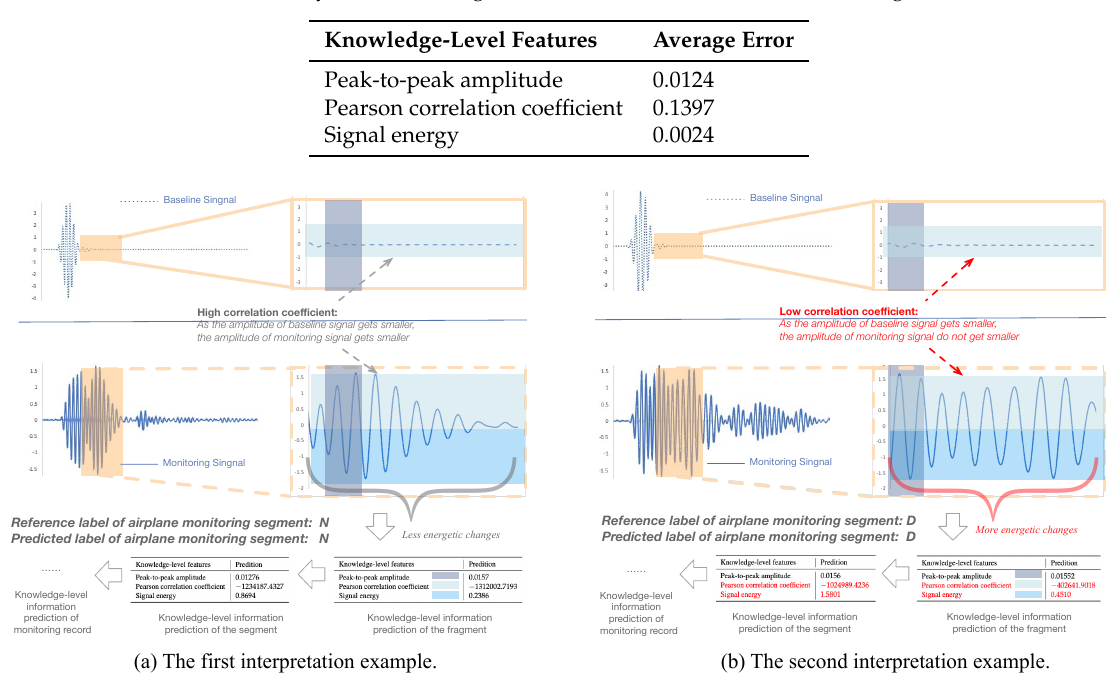
Table 4. Error analysis of knowledge-level features on the Aircraft Monitoring dataset.